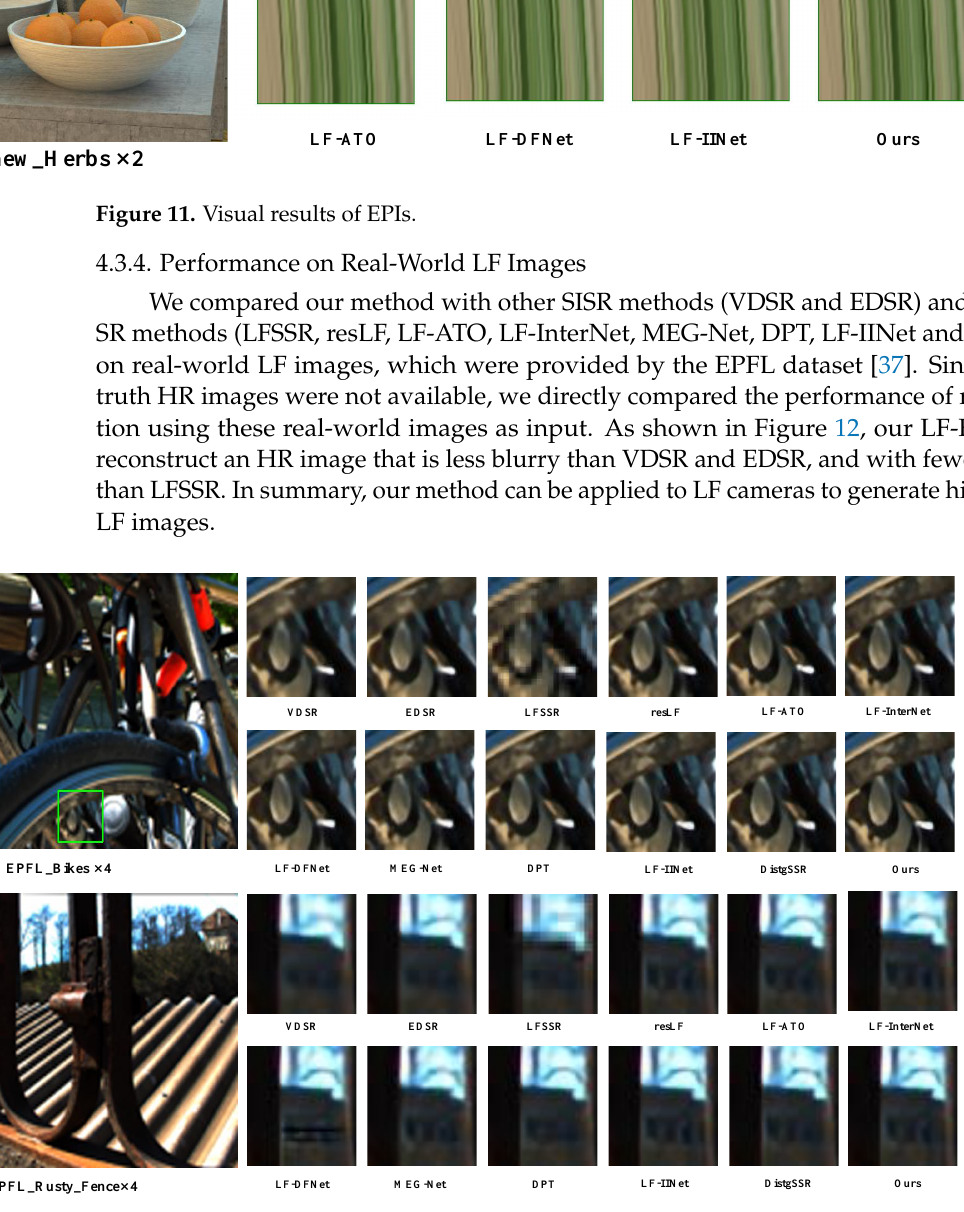
Figure 12. Visual results achieved by different methods on real-world